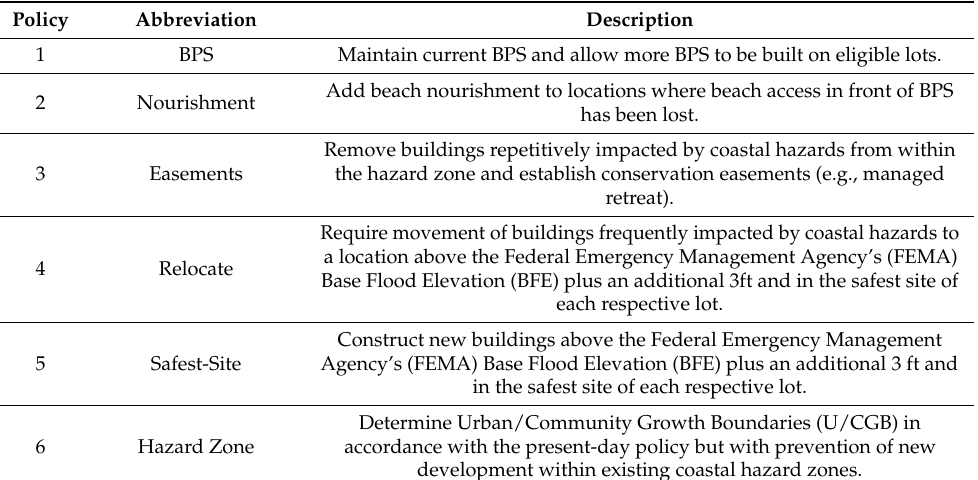
Figure 3. High-, medium-, and low-impact climate scenarios in terms of sea-level rise (SLR) from [20] ( left ), shift in wave climate from early to late century ( center ), and the mean yearly total water level (TWL) ( right ). The solid line in the significant wave height (SWH) probability distribution figure ( center ) represents a “present-day” SWH distribution. The dotted line to the right represents an increase to the present-day SWH distribution, while the dotted line to the left represents a decrease in the present-day SWH distribution by 2100. Bounds around the TWL ( right ) represent the max and min of the yearly average (after [43]). Table 1. Policies implemented in the analysis of individual management drivers.